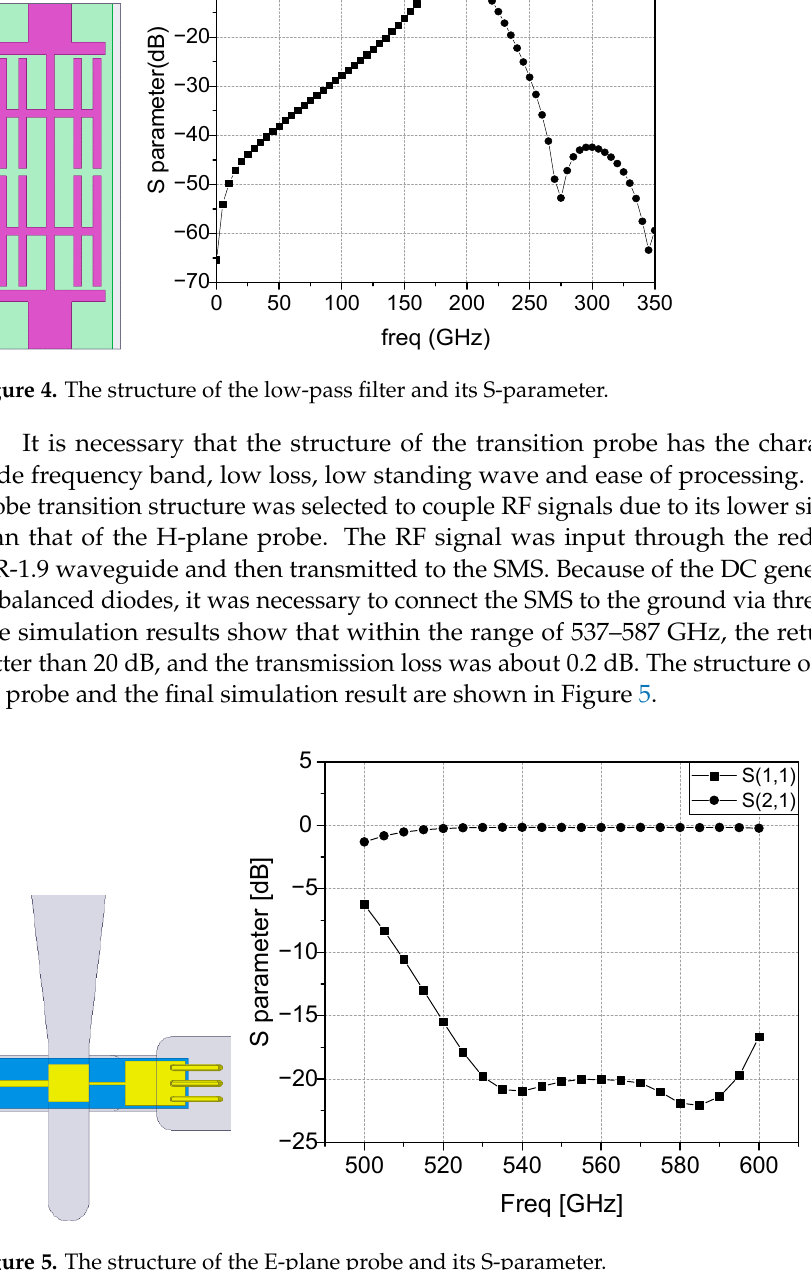
Figure 5. The structure of the E-plane probe and its S-parameter.